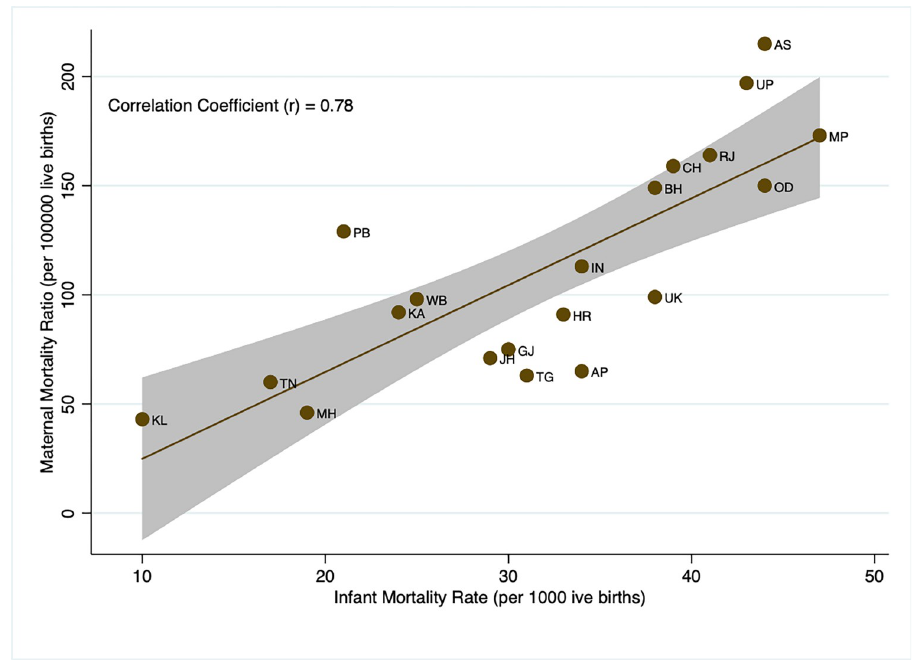
Fig 6. Correlation between IMR estimates from SRS and MMR estimates from